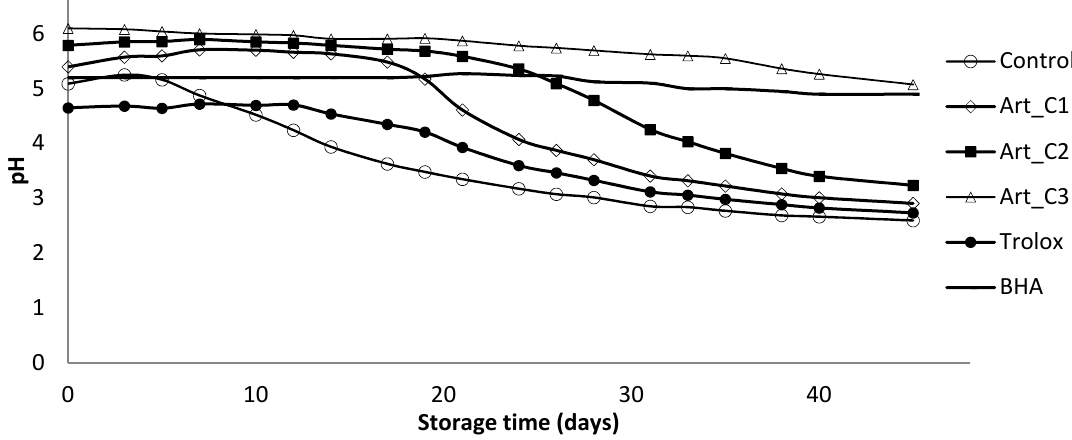
Figure 2. Evaluation of pH in a model food system (O/W emulsion 10% of oil)